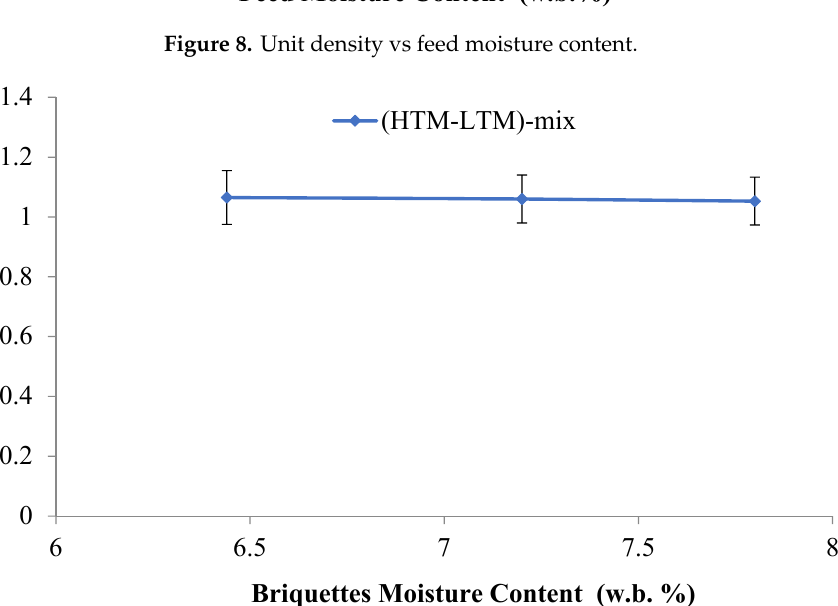
Figure 8. Unit density vs feed moisture content.